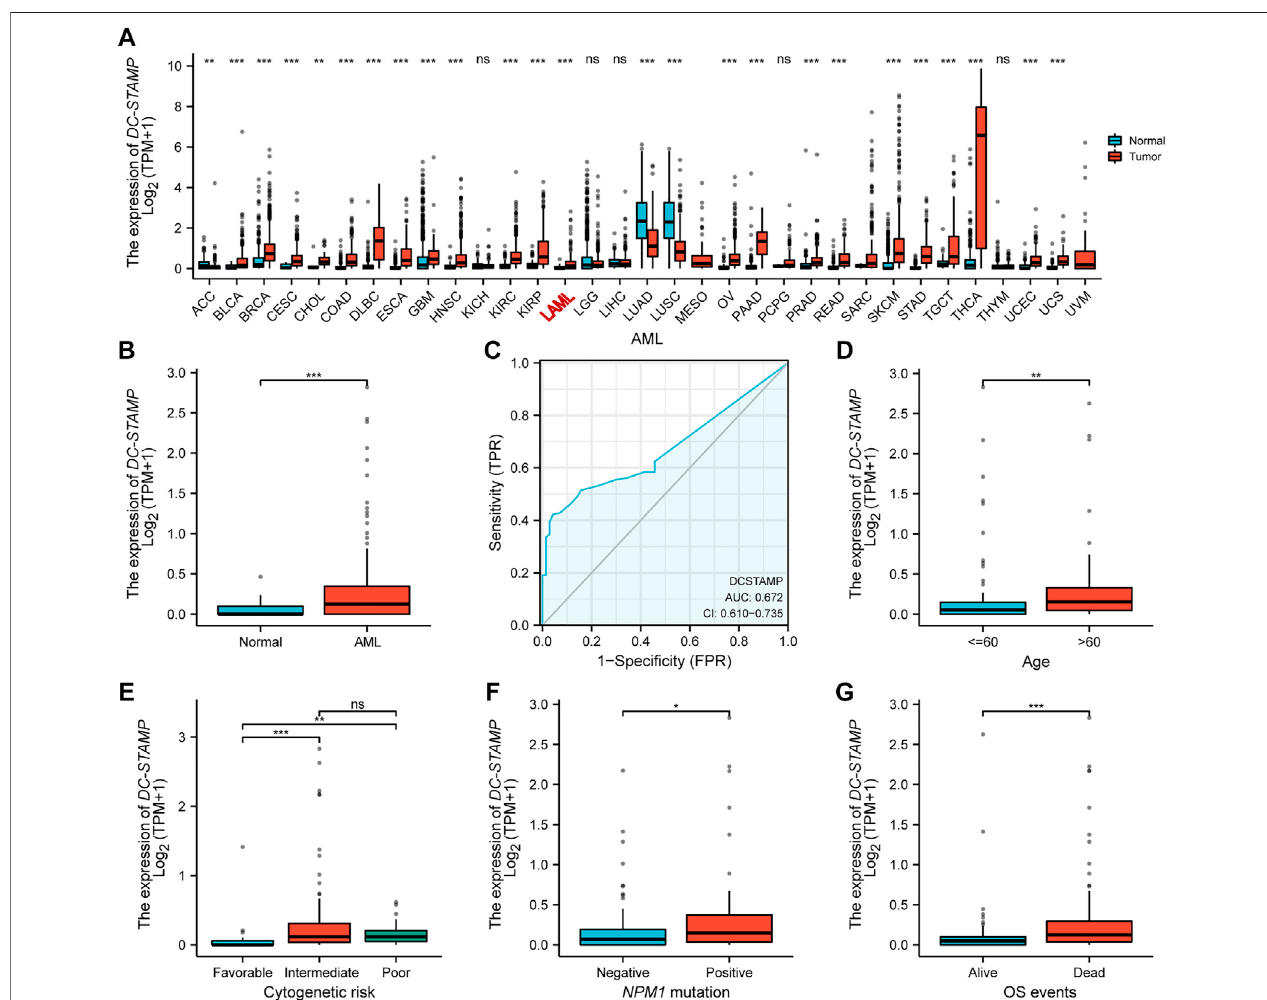
FIGURE 2 | High DC-STAMP expression was related with adverse clinical features. (A) Level of DC-STAMP expression in different tumors from TCGA and GTEx database. (B) Expressionlevelsof DC-STAMP inAML( n =173)andnormalsamples( n =70). (C) Receiveroperatingcharacteristicanalysis(ROC)of DC-STAMP inAML. Clinical characteristics including (D) age, (E) cytogenetic risk classi fi cation, (F) NPM1 mutation, and (G) OS events ( n = 153). Analysis between two groups of unpaired samples: Wilcoxon rank sum test, analysis among multiple groups of samples: Kruskal – Wallis rank sum test (ns p ≥ 0.05, * p < 0.05, ** p < 0.01, *** p < 0.001).